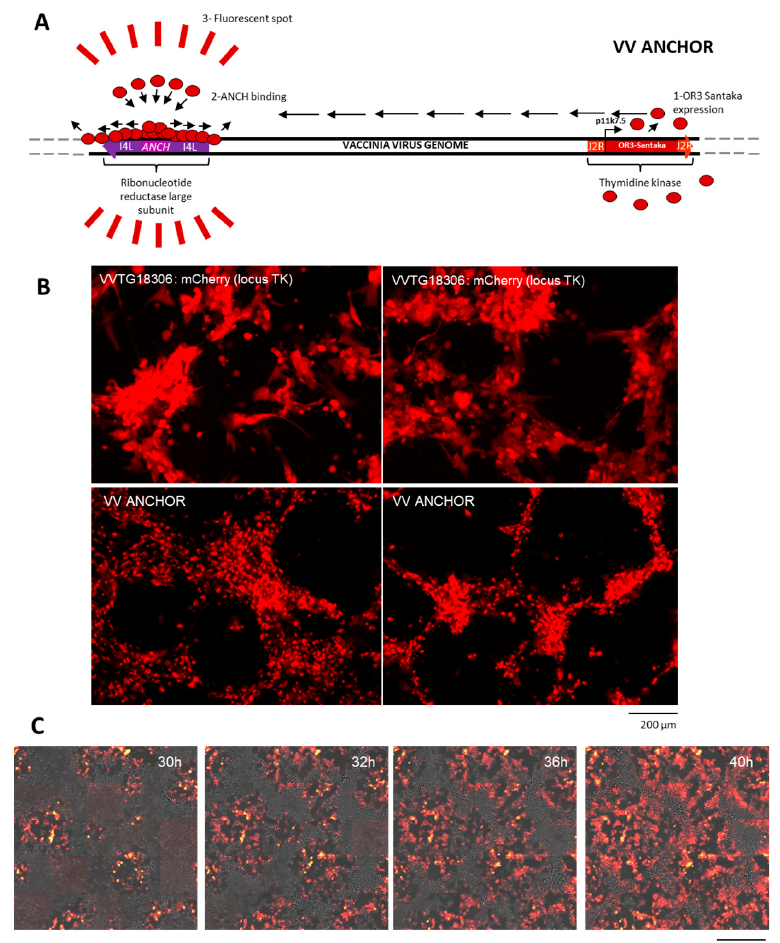
Figure 1. Construction of an autofluorescent ANCHOR tagged vaccinia virus (VACV) that maintains its oncolytic potential. ( A ) Schematic representation of the VACV ANCHOR genome. The ANCH sequence was inserted in the ribonucleotide reductase (RR) locus ( I4L ) by targeted homologous recombination, leading to a VACV Anch strain. This strain was then used to insert a p11K7.5 OR3-Santaka cassette at the TK locus (J2R). Upon infection, activation of the p11K7.5 promoter triggers expression of OR3-Santaka (red circles) that recognizes the ANCH sequence, binds and propagates by oligomerization. Accumulation of fluorescent protein onto the tagged viral DNA creates a fluorescent spot that corresponds to the position of the DNA in living cells. ( B ) Fluorescent signal (red) comparison between a classical VACV expressing mCherry (VVTG18036) and the VACV ANCHOR. CEF infected at a multiplicity of infection of 0.1 and 48 h later, the infected cells were observed with an inverted fluorescence microscope Nikon Eclipse Ti (magnification × 100), two fields of view are displayed for each construct. ( C ) HCT 116 cells infected with VACV ANCHOR at a MOI of 0.1 and imaged every two hours under an Arrayscan VTI microscope and showing accumulation of fluorescent spots (red). Reconstruction overlaying brightfield and Santaka channel are displayed over indicated time post-infection.